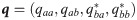
Results of the hyperparameter learning and posterior predictive checks.(A) Posterior (full lines) and prior (black dashed lines) distributions of the hyperparameters for the models fitted with two data folds. Hyperparameters q=(qaa,qab,qba*,qbb*) parameterize the right-hand side function fq of the dynamical model of seizure propagation (1). The text shows the split-chain scale reduction factor R^ and number of effective samples Neff. Note the different x and y ranges of the panels. (B) Results of the posterior predictive checks with the fitted models. In all panels, the red histogram shows the properties of the real seizure ensemble, while the solid lines show the mean of the hundred ensembles of simulated seizures and the shaded areas indicate the 5 to 95 percentile range. The panels show, left to right, distribution of the fraction of the seizing regions in one seizure, standard deviation of the onset times of seizing regions, and 10th, 50th, and 90th percentile of the onset times of seizing regions.